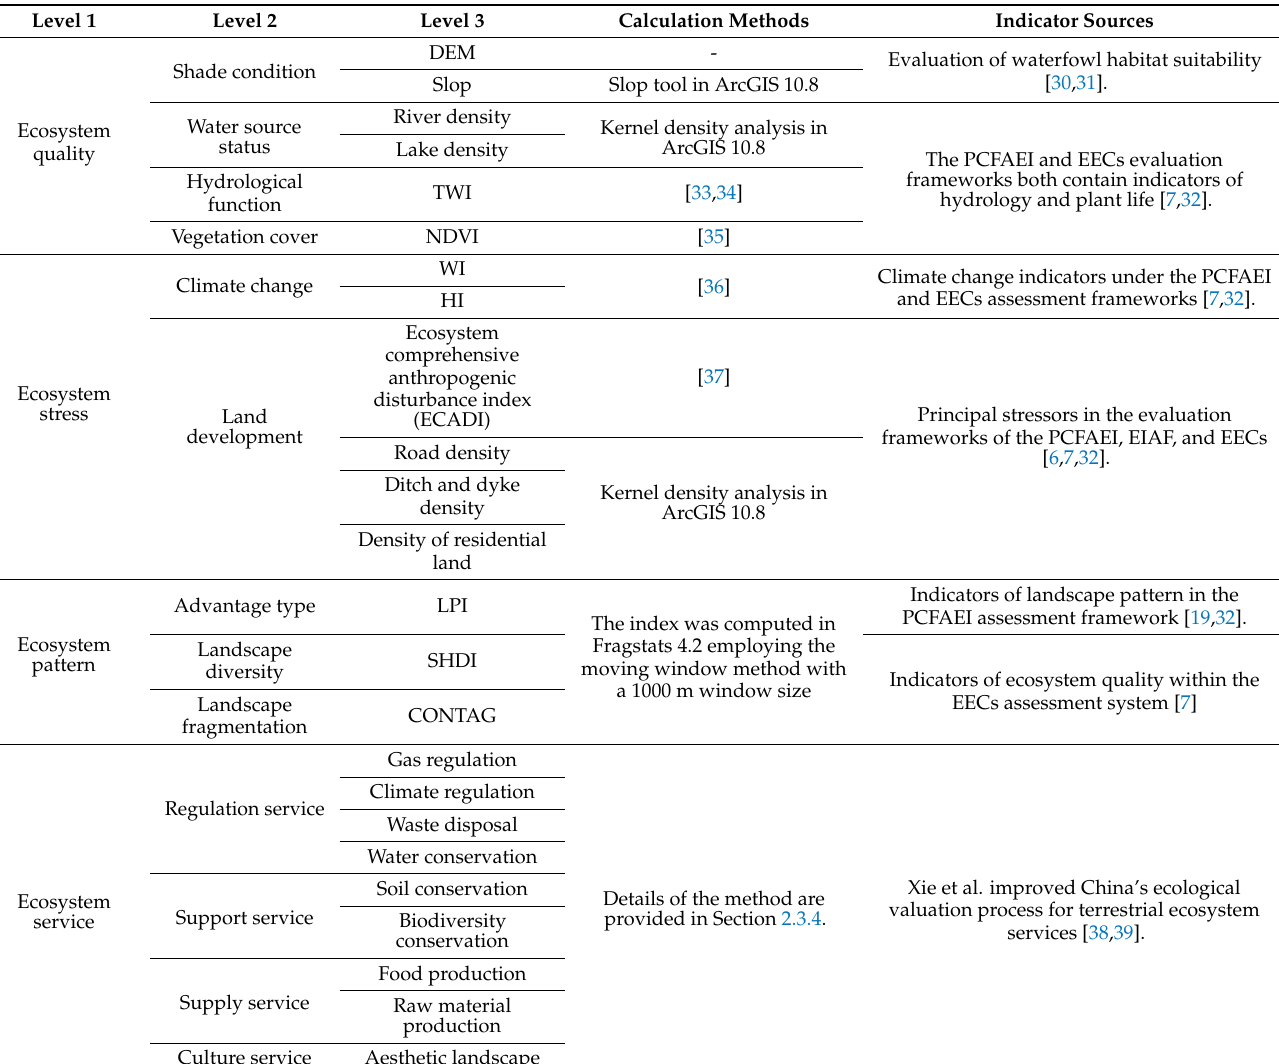
Table 3. “Quality-Pressure-Pattern-Service” ecosystem integrity evaluation factor